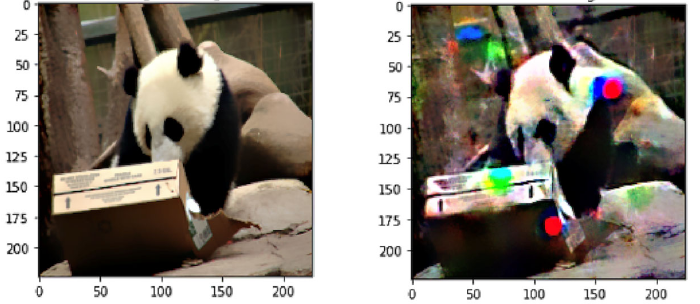
Figure 2. Visualization of adversarial sample from the robust poisoned classifier. The left image represents the clean image, and the right demonstrates the denoised smoothing.